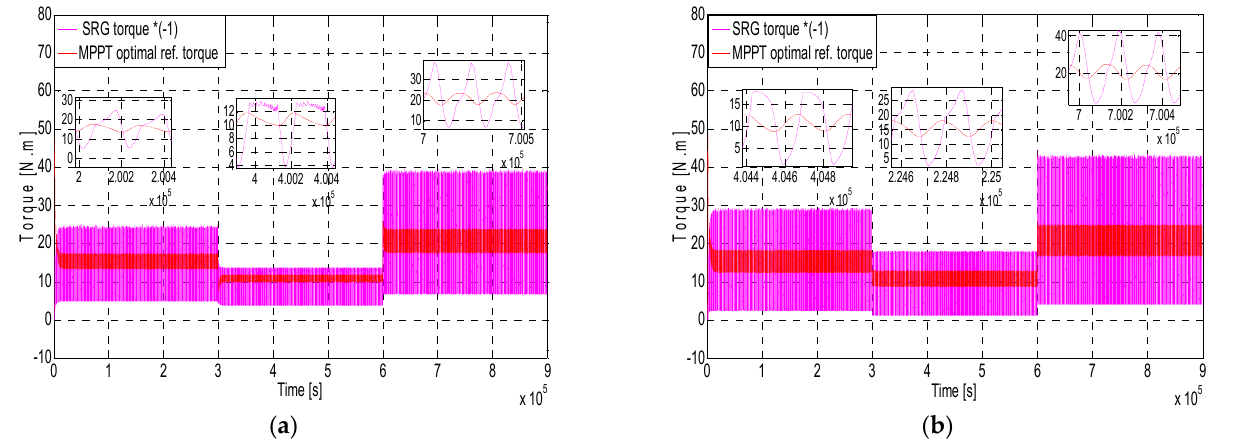
Figure 17. Optimal reference torque of the MPPT and the switched reluctance generator: ( a ) For θ (cid:2925)(cid:2924) (cid:3404) 19° and θ (cid:2925)(cid:2916)(cid:2916) (cid:3404) 38° ; ( b ) For θ (cid:2925)(cid:2924) (cid:3404) 22° and θ (cid:2925)(cid:2916)(cid:2916) (cid:3404) 35° .